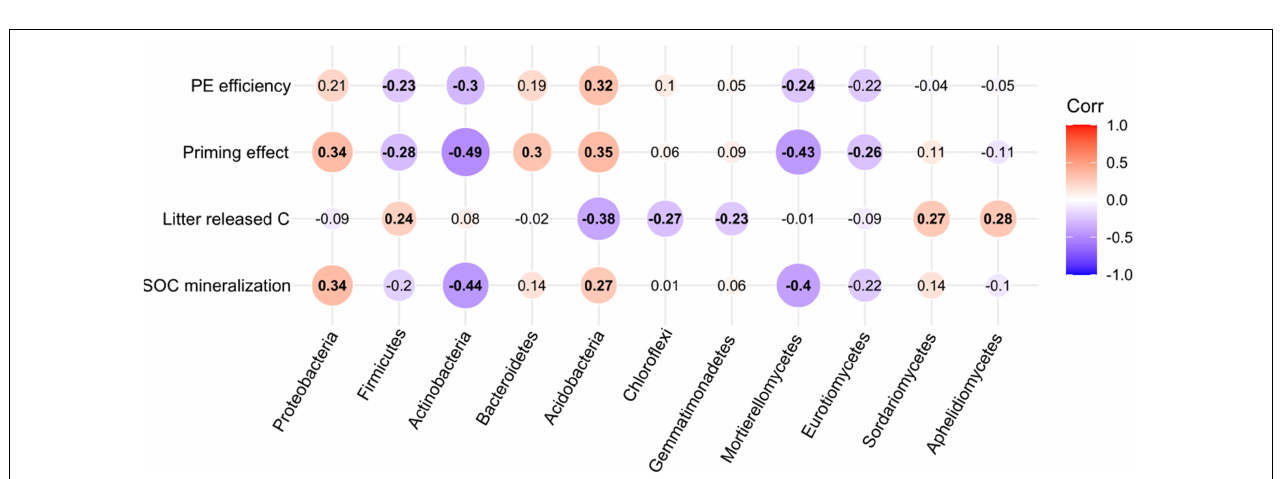
FIGURE 7 | The effect of critical bacterial and fungal taxa on SOC mineralization, litter-released carbon, priming effect, and priming efficiency. The numbers in the center indicate the correlation (Spearman’s r values) between microbial taxa and soil processes across all samples.